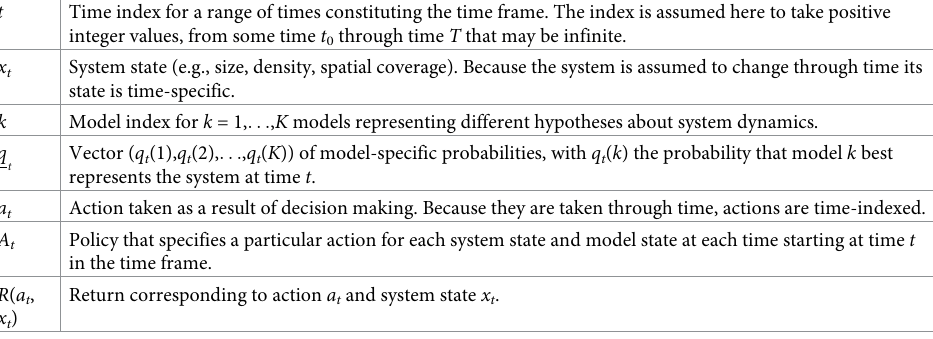
Table 1. Notation used to characterize dynamic decision making and valuation under structural